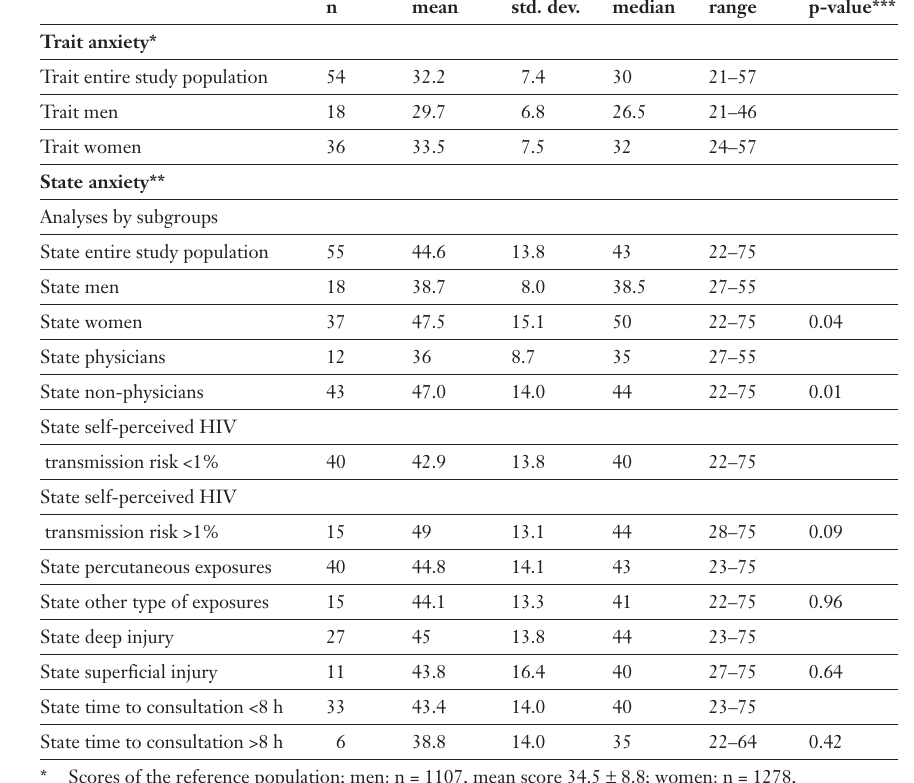
Trait and state anxiety at the time of reporting occupa- tional exposure.